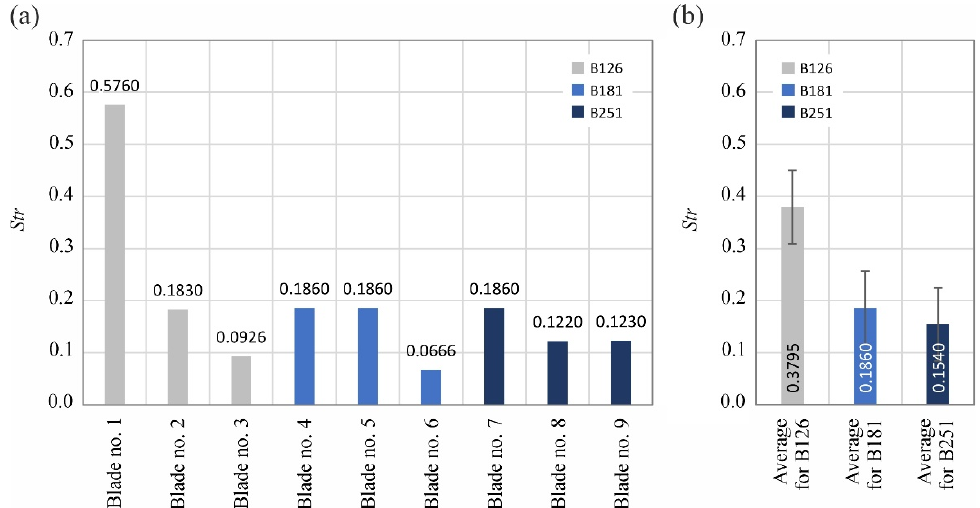
Figure 15. Changes in the texture aspect ratio of the surface Str : ( a ) results for nine blades selected for surface texture measurements; ( b ) average values determined by the size of the cBN abrasive grain of the grinding wheel used (error bars represent the standard error equal to the standard deviation σ divided by the square root of the total number of samples).